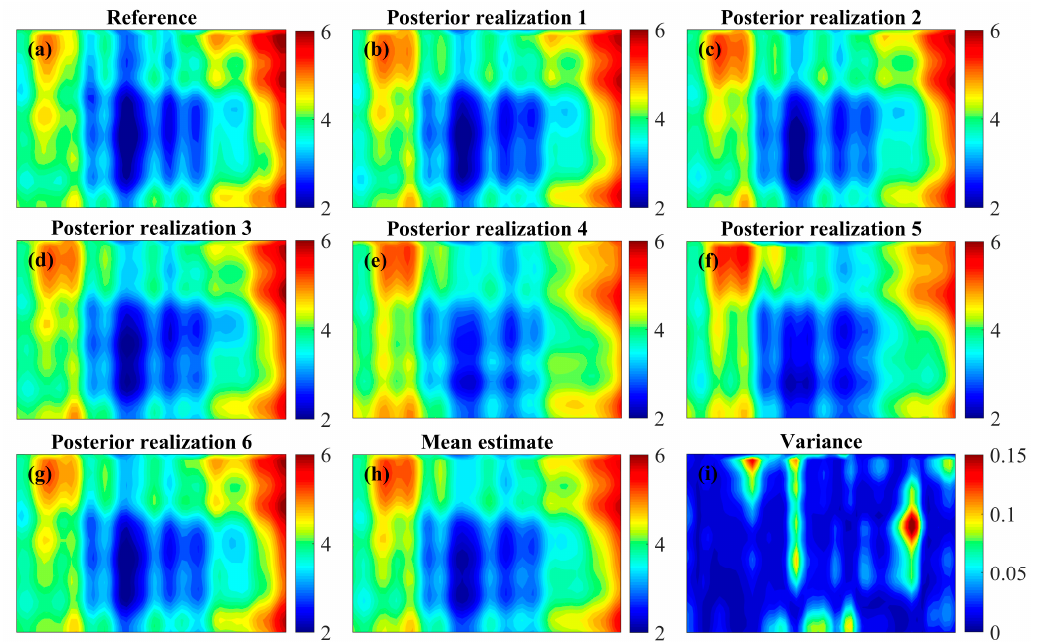
Figure 15. ( a ) is the reference log-conductivity field. ( b – g ) represent six posterior realizations of the log-conductivity field generated from the last ensemble. ( h ) represents the mean estimate of the log-conductivity field of the last ensemble. ( i ) represents the estimation variance of the log-conductivity field of the last ensemble.